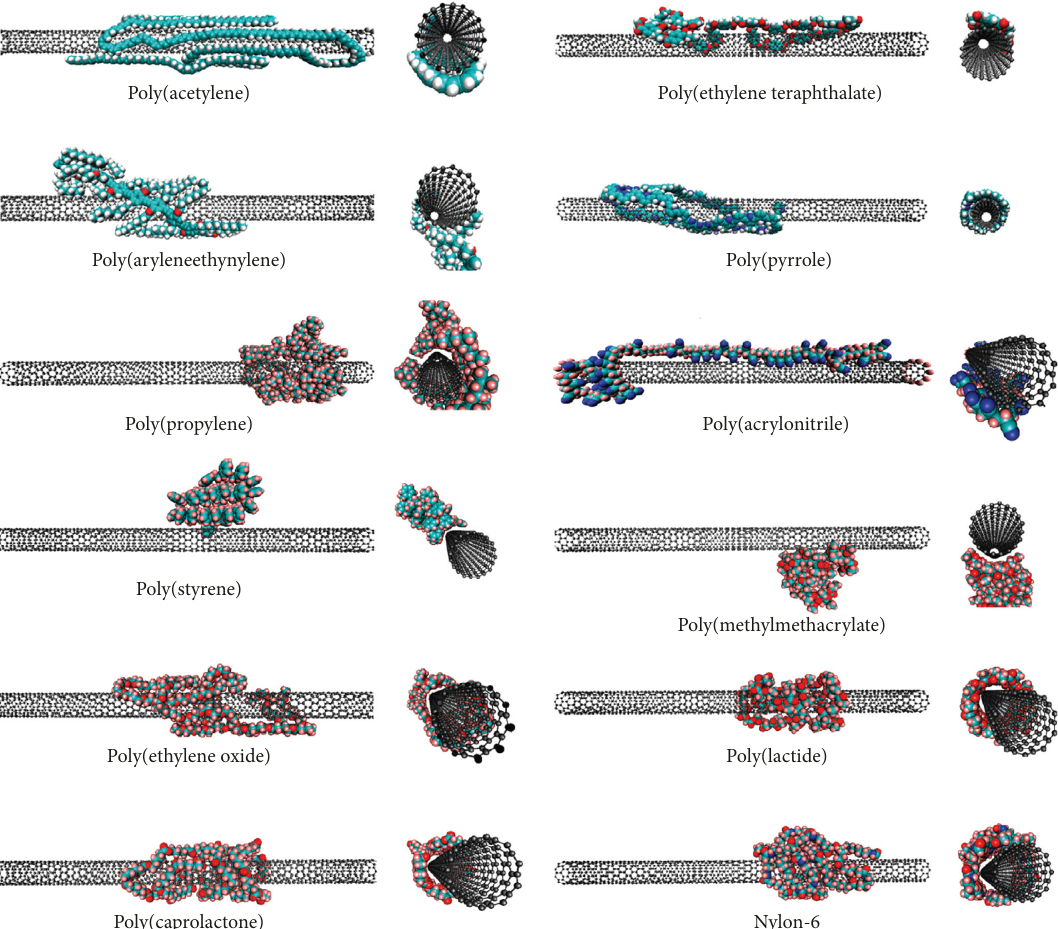
Figure 11: Possible wrapping conformations obtained from a model used to illustrate potential interactions at the interface between single- walled carbon nanotubes and different polymer matrices at the 3.2ns time step in molecular dynamics simulations. The polymers have different degrees of flexibility in the structure of their respective backbone (adapted with permission from references [188, 189]; copyright 2010, American Chemical